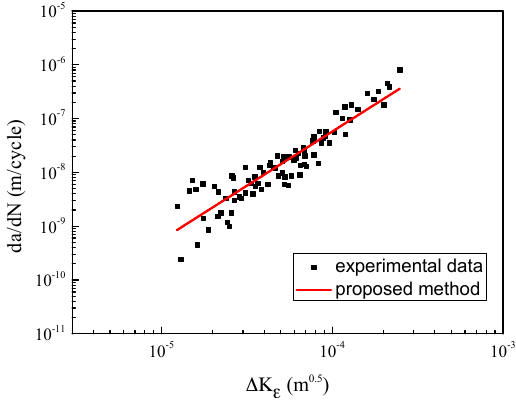
Figure 13. Crack growth rate of AZ31 magnesium alloy.